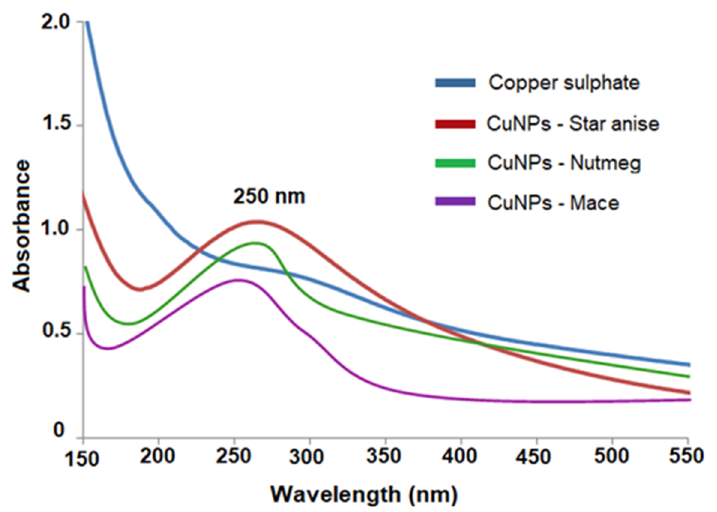
Figure 2. UV-Vis spectroscopic analysis of test samples after 24 h of incubation, showing phytogenic synthesis of CuNPs with the maximum absorption at 250 nm.